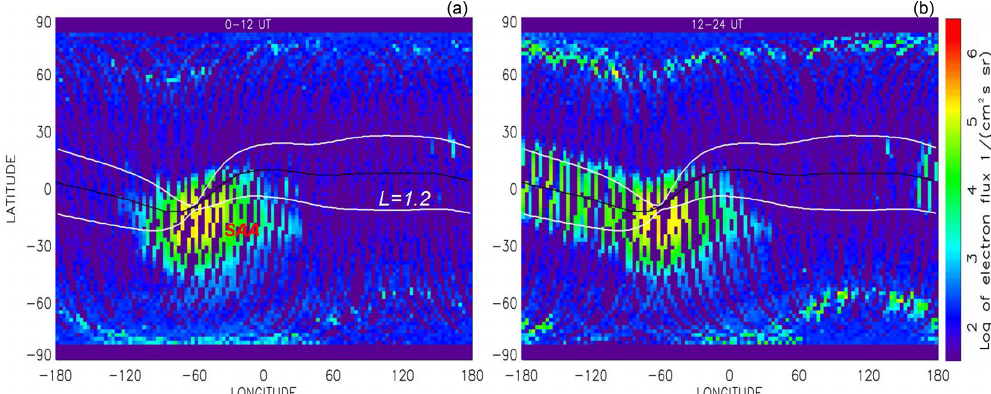
Figure 1. Geographic distribution of > 30keV electron fluxes measured by five NOAA/POES satellites on 1 August 2008 for the time interval (a) 00:00–12:00UT, before the electron flux enhancements, and (b) 12:00–24:00UT, during the enhancements. The electrons are detected in the vertical direction. In the forbidden zone those electrons are quasi-trapped. The electron fluxes enhanced largely during non- storm conditions after 12:00UT. The forbidden zone is bounded by L = 1 . 2 (white lines) and located outside of the South Atlantic Anomaly (SAA) at equatorial to low latitudes. Drift L shells are calculated from the IGRF-2005 model. The solid black curve indicates the dip equator.